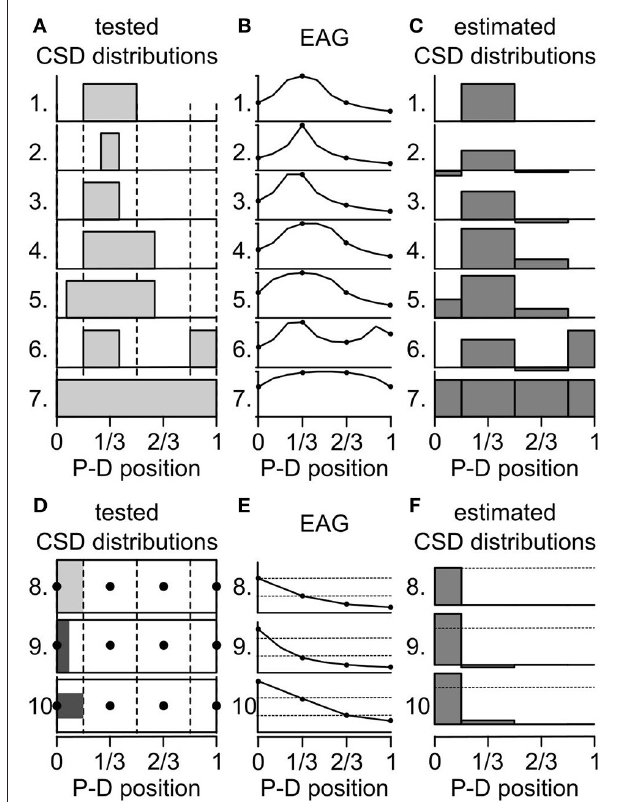
FIGURE 4 | Biased induced by the compartmentalization of the antenna. (A) Seven artificial CSD distributions were tested for qualitative biases. At each antennal position along the proximo-distal axis, the CSD was either set to 0 or to 1 (gray bars). The dashed lines delineate the four compartments of an antenna model. P-D, proximodistal. (B) The graphs show the EAG distributions that were predicted from the test CSD distributions from (A) labeled with the same numbers. The prediction was calculated with a model of antenna with 10 compartments. The amplitude of the EAG was normalized. Only four positions (dots) were used to calculate the CSD. (C) The graphs show the CSD distribution that were estimated with a model with four compartments applied on the EAG distributions from panel (B) . (D) Three additional CSD distributions were tested for quantitative biases. The CSD distributions are shown as unfolded cylinders, the four compartments of the model are delineated by dotted lines and the position of the electrodes are indicated by black dots. The CSD was set to 1 (light gray) in the proximal compartment (8) or to 2 (dark gray) in one half of the proximal compartment: either the proximal half (9) or the central half (10). (E) EAG distributions predicted from the test CSD distributions from (D) . The amplitudes of the EAG were not normalized. For comparison, dashed lines indicate the amplitudes predicted for the two most proximal electrodes in the distribution number 8. (F) CSD distribution estimated from the EAG in (E) . For comparison, dashed lines indicate the amplitude of CSD estimated in the proximal compartment in the distribution number